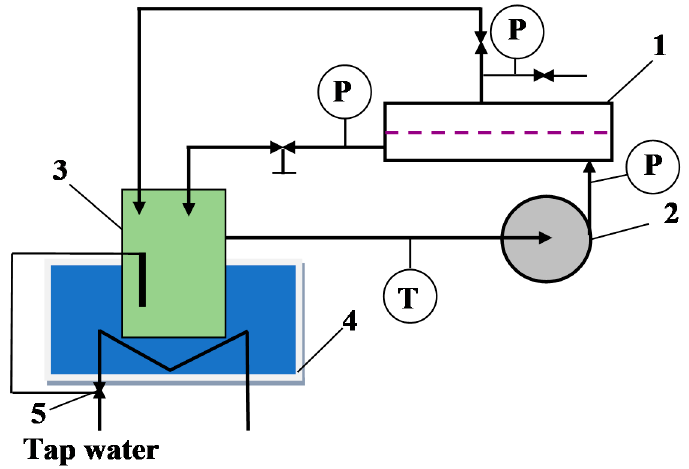
Figure 3. Experimental NF set-up. 1—SEPA-CFII module, 2—pump, 3—feed tank, 4—cooling bath, 5—thermostatic Grundfos valve, P—manometer, T—thermometer.